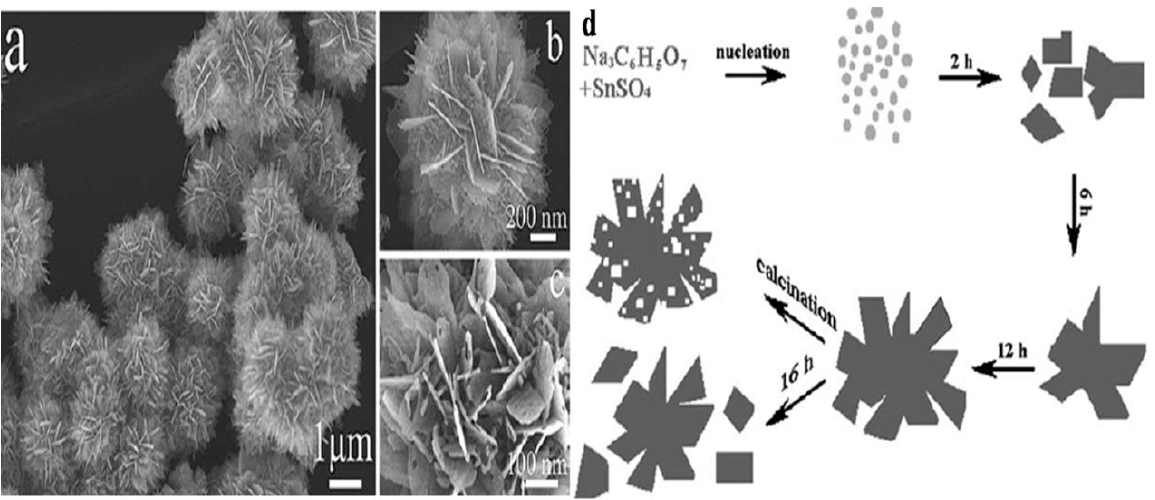
Figure 3. ( a ) SEM image of SnO 2 porous 3D architectures after annealing the precipitates at 600 ◦ C for 2 h; ( b , c ) magnified SEM images; ( d ) schematic representation of the process of formation of SnO 2 hierarchical nanosheets. (Reprinted with permission from [69]. Copyright 2011, the Royal Society of Chemistry, London).